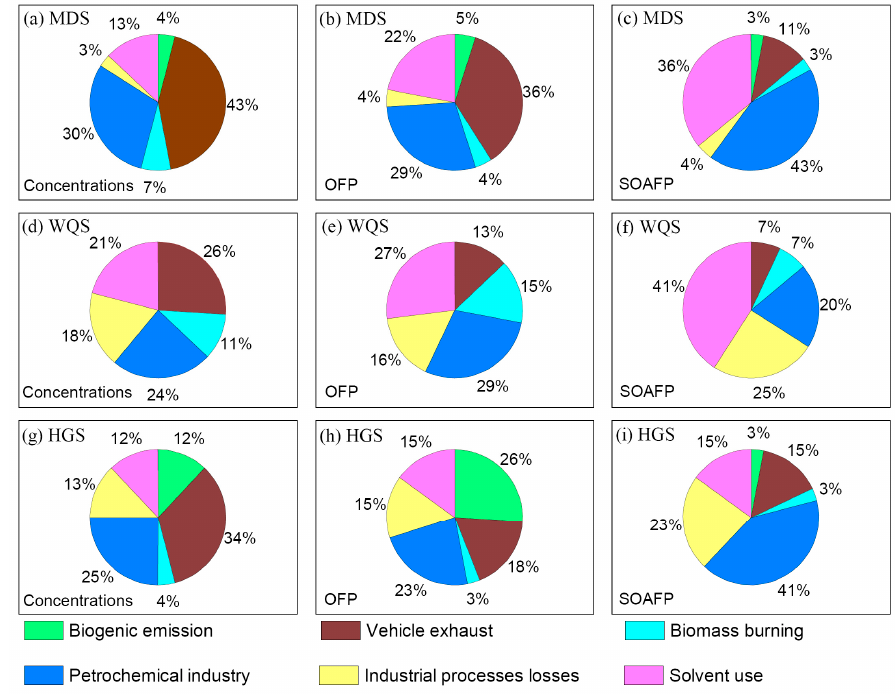
Figure 11. The source contributions to VOCs ( a ) concentrations at MDS, ( b ) OFP at MDS, ( c ) SOAFP at MDS, ( d ) concentrations at WQS, ( e ) OFP at WQS, ( f ) SOAFP at WQS, ( g ) concentrations at HGS, ( h ) OFP at HGS, and ( i ) SOAFP at HGS.